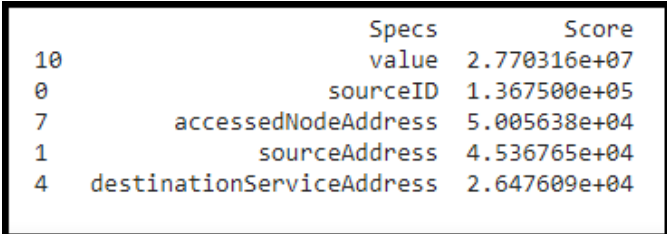
Figure 9. Illustration of the relationship between the dataset features.